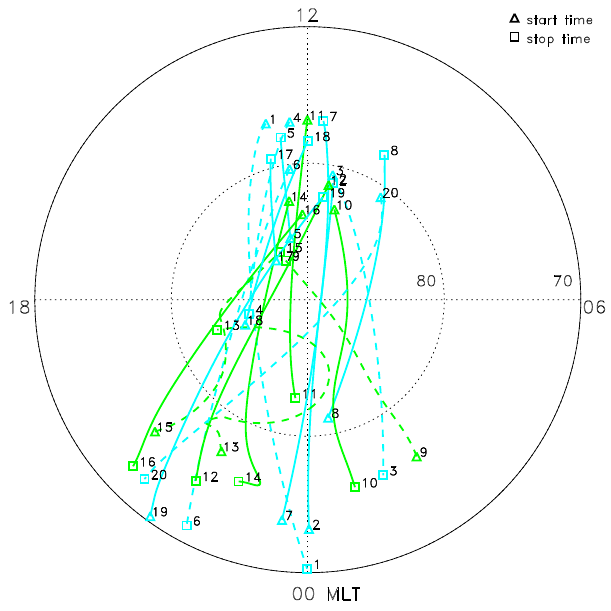
Fig. 2. Projection of the 20 passes into the polar ionosphere along the Tsyganenko-2001 model magnetic field. Solid and dashed lines are for orbits in the Northern and Southern Hemispheres, respec- tively. Nightside Perigee orbits (NP) are shown in blue, Dayside Perigee orbits (DP) in green, as in Fig.